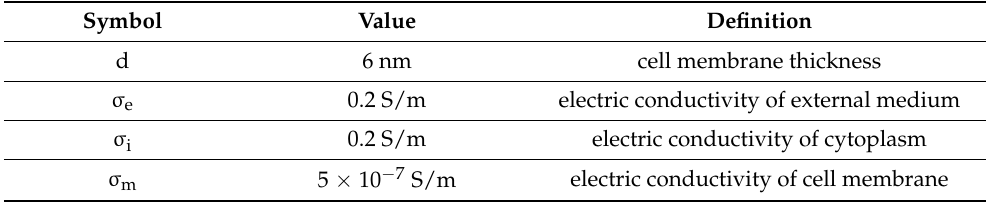
Table 5. Parameters of the 2 D